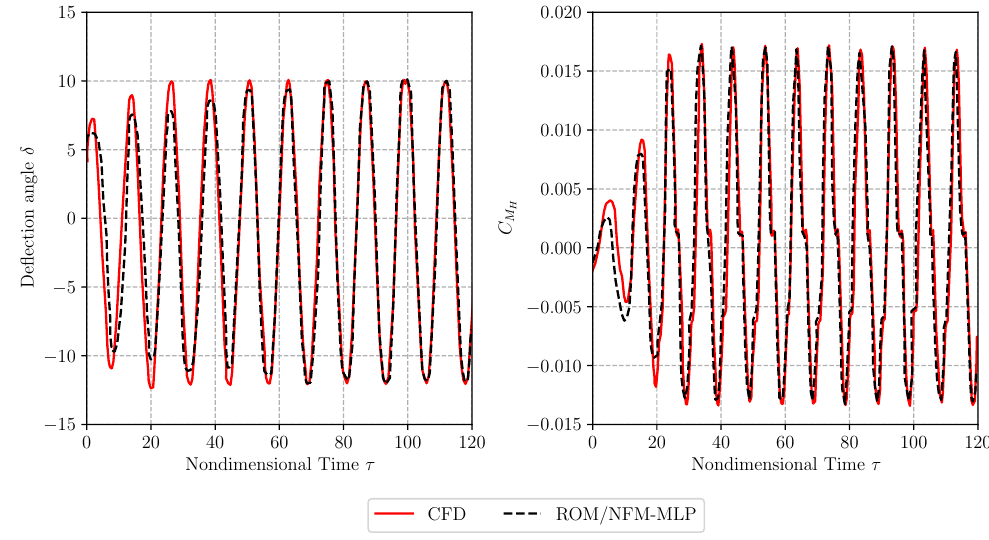
Figure 11. Responses of the resulting aileron deflection angle and hinge moment coefficient at a selected buzz condition (NACA65 1 213 airfoil, Ma ∞ = 0.82, Re = 20.7 of the NFM-MLP ROM are compared to the reference CFD